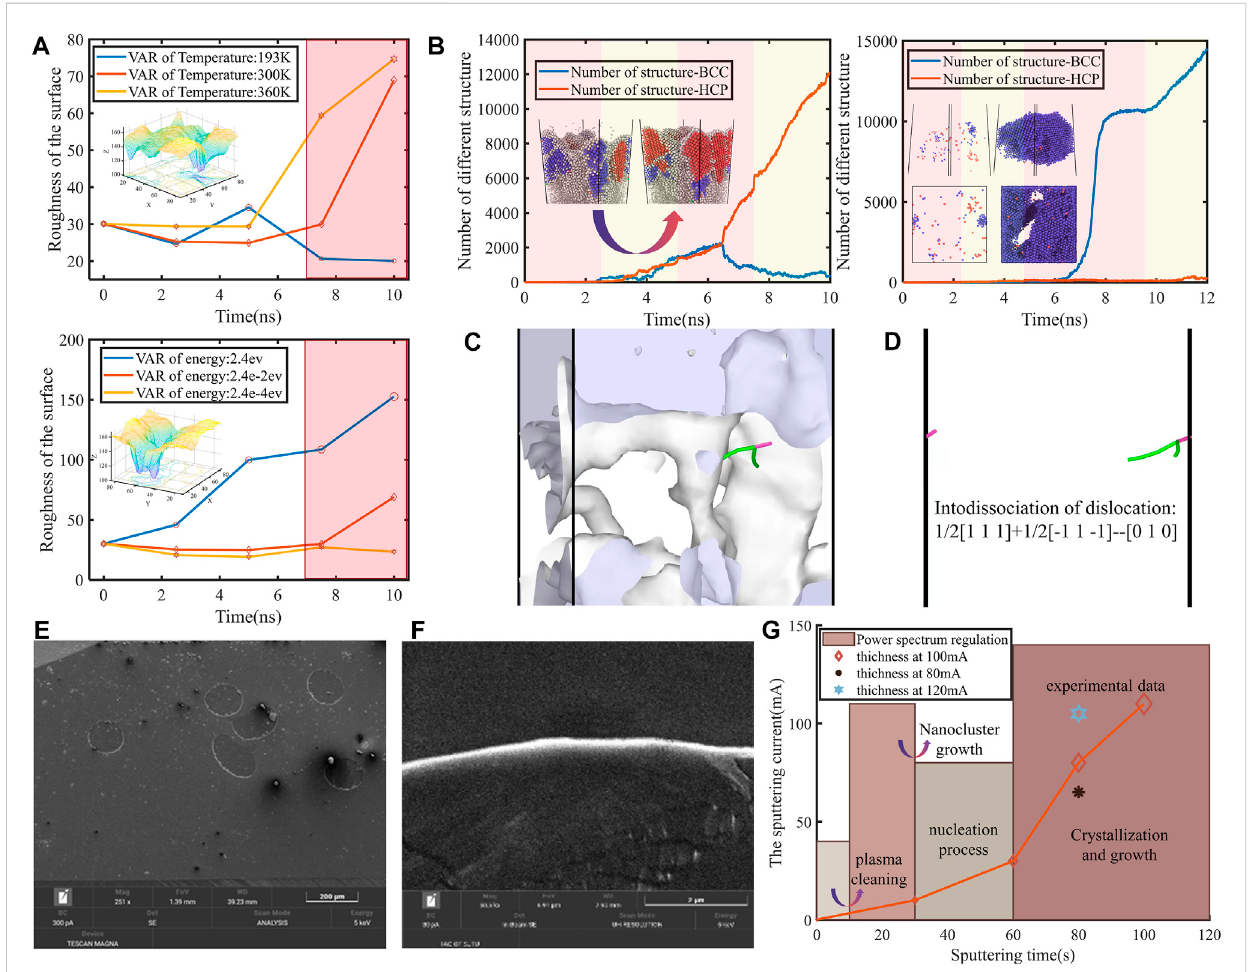
FIGURE 2 (A) Surface properties based on substrate temperature and sputtering energy. Higher energies lead to higher surface roughness and the pink area is the stage where a large number of nuclei grow. Large areas of polymer are covered and this stage is a critical period for the reaction mechanism. (B) The different undertones represent different periods of sputtering, with relaxation occurring at the end of each period. The free energy determines the thermodynamic preference. It is up to diffusion and particle relaxation to determine whether thermodynamic processes occur. The second picture shows the formation of massive individual crystals by suppressing nucleation until explosive nucleation occurs when the thermodynamic driving force becomes large. (C) Schematic diagram of dislocation analysis. Within a certain range of dislocation density, the plasticity of the material increases with more dislocations or twins, that is, it can withstand higher external loads and has better ductility. (D) The movements of dislocations, the green line representsthedislocationswithBurgersvector[111]andmagnetlinerepresentsthedislocationwithBurgersvector(001). (E) Analysisofthecross-section of the encapsulated polypropylene and the thickness of the titanium coating. Schematic showing the variation with growth for the thin fi lm layer, the circularpolypropylene fi berswereembeddedinparaf fi nwaxandfrozensliced. (F) Apartial magni fi cationoftheTilayerisusedtoaccurately measurethe thickness. (G) The thickness of the fi lm growth is used to predict the cycle time in sputtering, then adjustments are made. The thickness variation of the fi lm layer is also veri fi ed experimentally for different sputtering